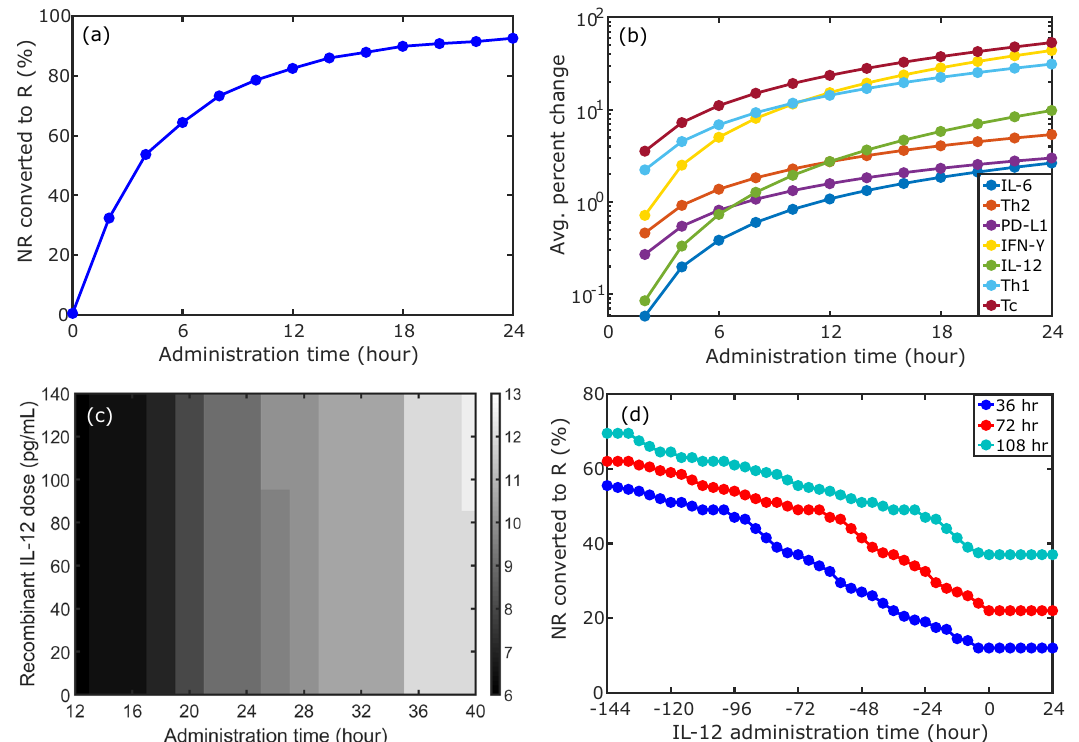
Fig. 4 Simulation results of IL-6 inhibitor and recombinant IL-12 combined with the nivolumab treatment protocol for non-responders to anti-PD1 immunotherapy. a Percent of patients converted from non-responders to responders at a fi xed single dose of 10 pg/mL recombinant IL-12 administered at different times before nivolumab treatment protocol. b Corresponding absolute value of average percent change of cytokine and T-cell populations. Average was taken over 1000 patients, calculated between the time of recombinant IL-12 administration and just prior to nivolumab treatment protocol. For IL-6, Th-2, and PD-L1, average percent change is negative, corresponding to inhibition; for all other quantities, average percent change is positive. Change in the IL-12 level does not include the recombinant IL-12 concentration. For ( a , b ), the 1000 patients were chosen from the non-responder group by selecting patients with the smallest tumor size after the nivolumab treatment protocol (note that the tumor size was larger than before nivolumab treatment per our de fi nition of “ non-responder ” ). c Percent of 200 randomly selected non-responders converted to responders as a function of single dose strength of recombinant IL-12 and the administration time. Minimum dose administered was 1 pg/mL. For ( a – c ), administration time is the number of hours recombinant IL-12 was given prior to the start of the nivolumab treatment protocol. For IL-6 inhibition, corresponding plots ( a – c ) are very similar, see Supplementary Fig. 2. d Triple combination therapy comprised of single dose 10 pg/mL recombinant IL-12, single dose IL-6 inhibitor (maximum 1% reduction in IL-6 production rate), and nivolumab treatment protocol. Percent of 200 randomly selected non-responders converted to responders as a function of recombinant IL-12 administration time for different IL-6 inhibition times is shown. IL-6 inhibitor was given before nivolumab treatment, and the reported legend times are the hours administered prior to the start of nivolumab treatment protocol. IL-12 administration times are measured relative to the particular IL-6 administration